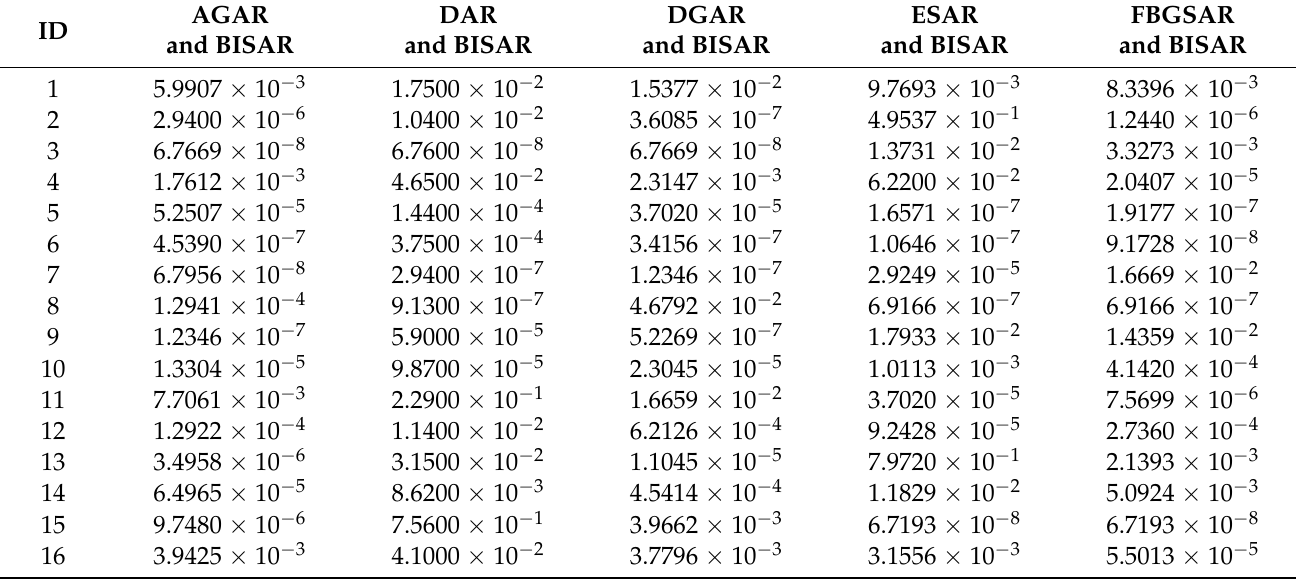
Table 6. p -values for comparing stabilities (label